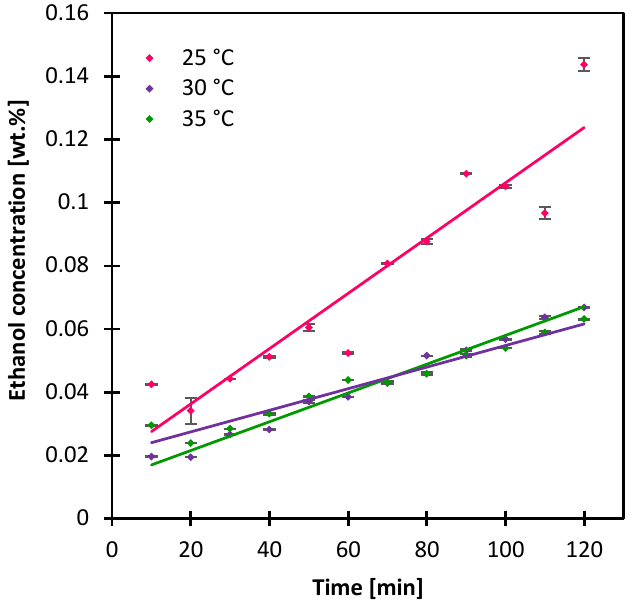
Figure 8. Ethanol concentration in the crystallizing solution at the first 120 min, with variation of operating temperature. Lines are added to guide the